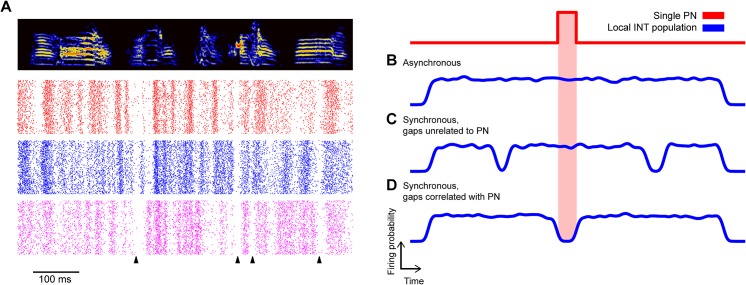
Inhibitory neuron firing patterns and three models for projection neuron/inhibitory neuron relationships.
a, Raster plots of three nearby (<200 μm) inhibitory neurons recorded during singing from the same bird. Synchronous pauses are marked with a black triangle. Shown to the right are three conceptual models of timing relationships between inhibitory and projection neuron activity. b, Interneuron firing patterns are uncorrelated in local ensembles, leading to a net local inhibition that is weakly modulated in time. c, Gaps in inhibitory neuron firing activity are locally correlated, leading to synchronous pauses in inhibition, but these pauses are unrelated to projection neuron activity. d, Gaps in inhibitory neuron firing activity are locally correlated, and contribute to defining projection neuron firing times. PN, projection neuron; INT, interneuron.